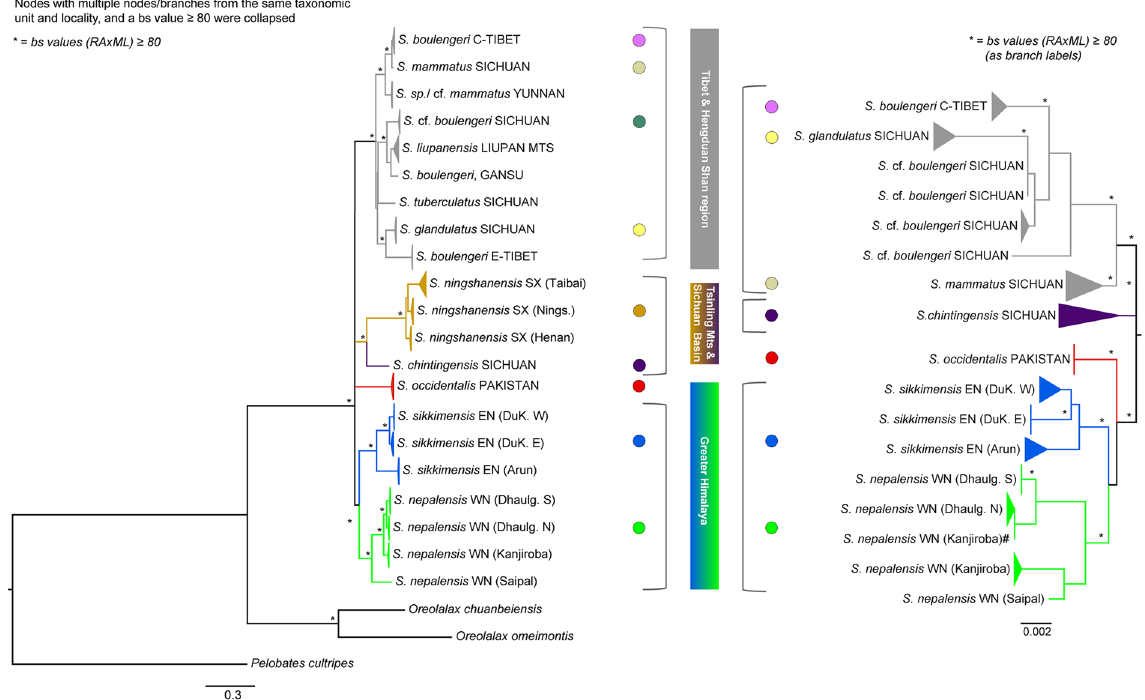
Figure 2. Phylogenetic trees based on mitochondrial and nuclear markers inferred by maximum-likelihood (ML) analyses. Phylograms were obtained with the program RaxML 88 based on the combined 16 s , co1 , cyt and nd4 mtDNA data (left) and the bfib7 , ccnb2 and rag1 nuDNA data set (right). Scutiger ( S .) is followed by the species name and by locality information (Table S5 for sample IDs). An asterisk above branches indicates bootstrap support values ≥ 80. For clarity, branches representing individuals belonging to the same taxonomic unit were collapsed. Colour codes correspond to those of localities in Fig. 1 and Supplementary Fig. S3. # One sample (A2014-13) from Kanjiroba Himal was placed differently in the mtDNA and nDNA tree (for details text). Inconsistencies occurring between samples in mitochondrial vs . nuclear trees are explained by availability of either samples or only sequence information from previous work (for details Table S5). C-Tibet = Central Tibet; Dhaulag. N/S = Dhaulagiri North/South; DuK.E/W = Dudh Koshi River East/West; E-Nepal = East Nepal; E-Tibet = East Tibet; Liupan Mts = Liupan Mountains; Nings. = Ningshan; SX =